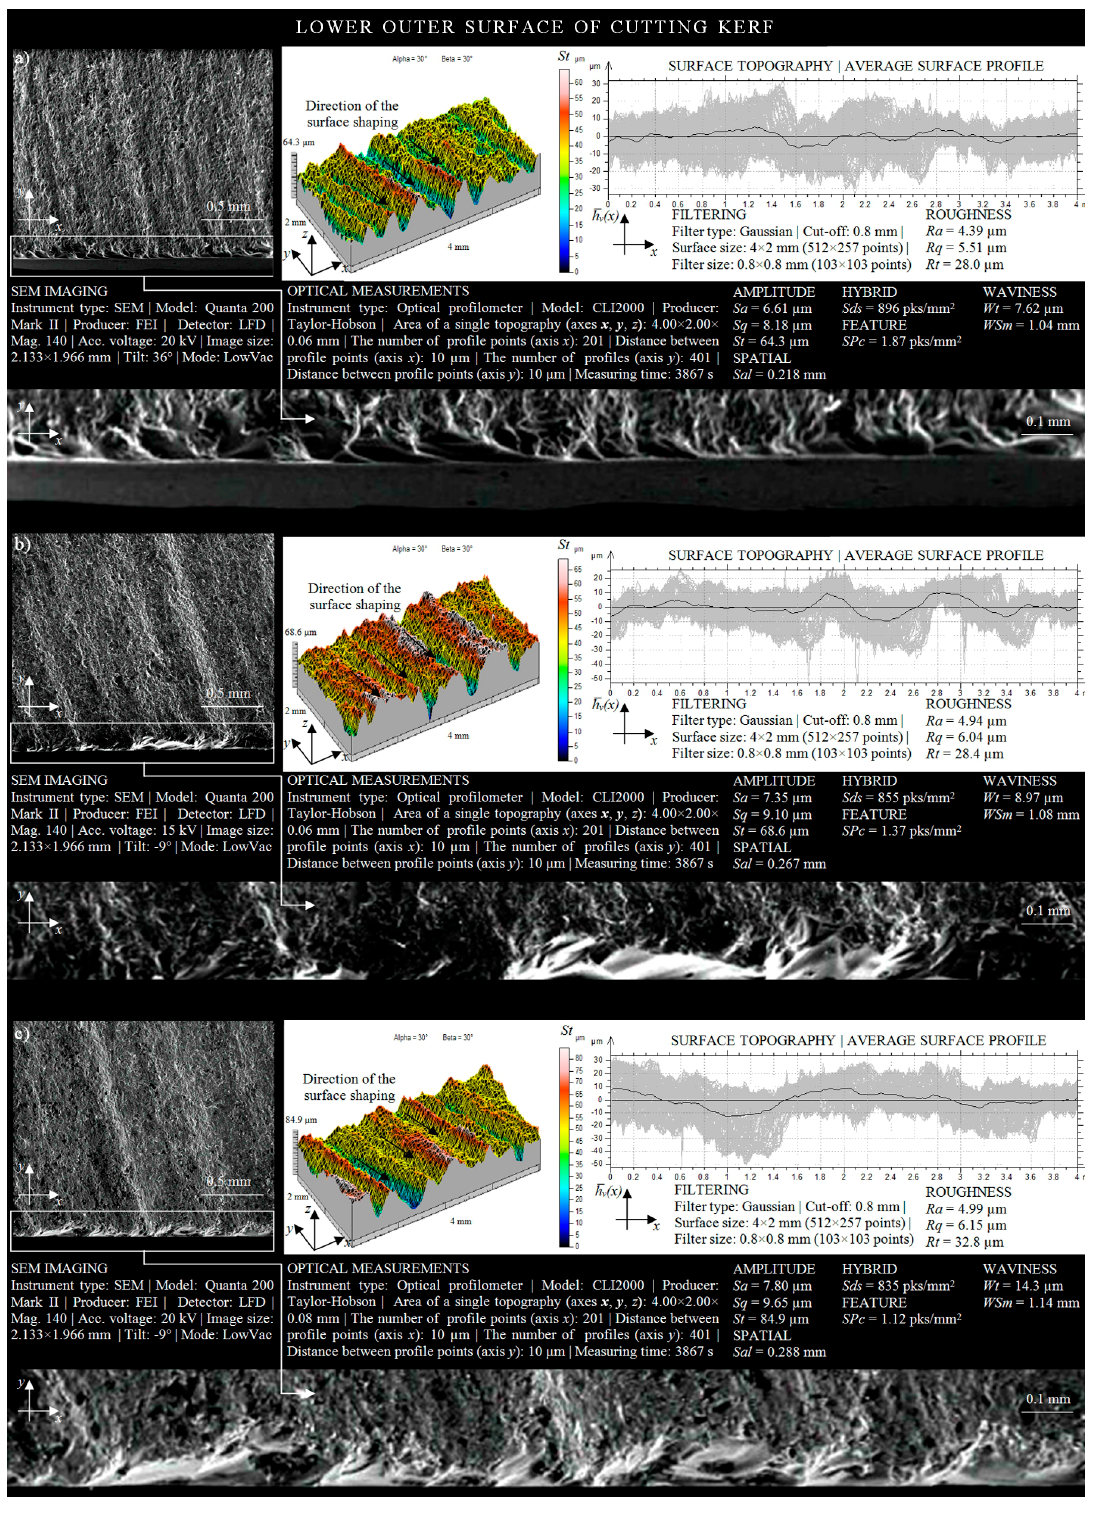
Figure 9. Collection of selected results of experimental studies obtained for the lower OS in a situation where the AWJ entered the sample surface ( l = 1.5 mm, d o = 0.38 mm, d f = 0.76 mm, m a = 0.336 kg / min, v = 427 mm / min, p = 360 MPa, g = 8 mm): ( a ) r = 50 mm; ( b ) r = 35 mm; ( c ) r = 15